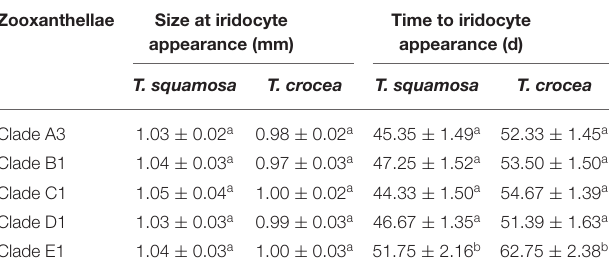
Different superscript letters in each column indicate significant differences, P <